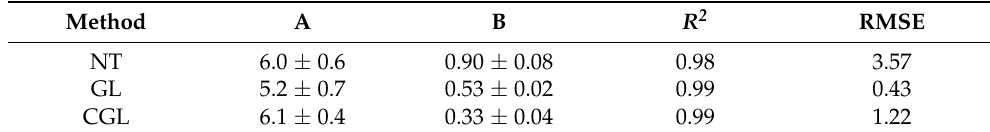
Table 2. Parameters of the Halsey equation (Equation (5)).